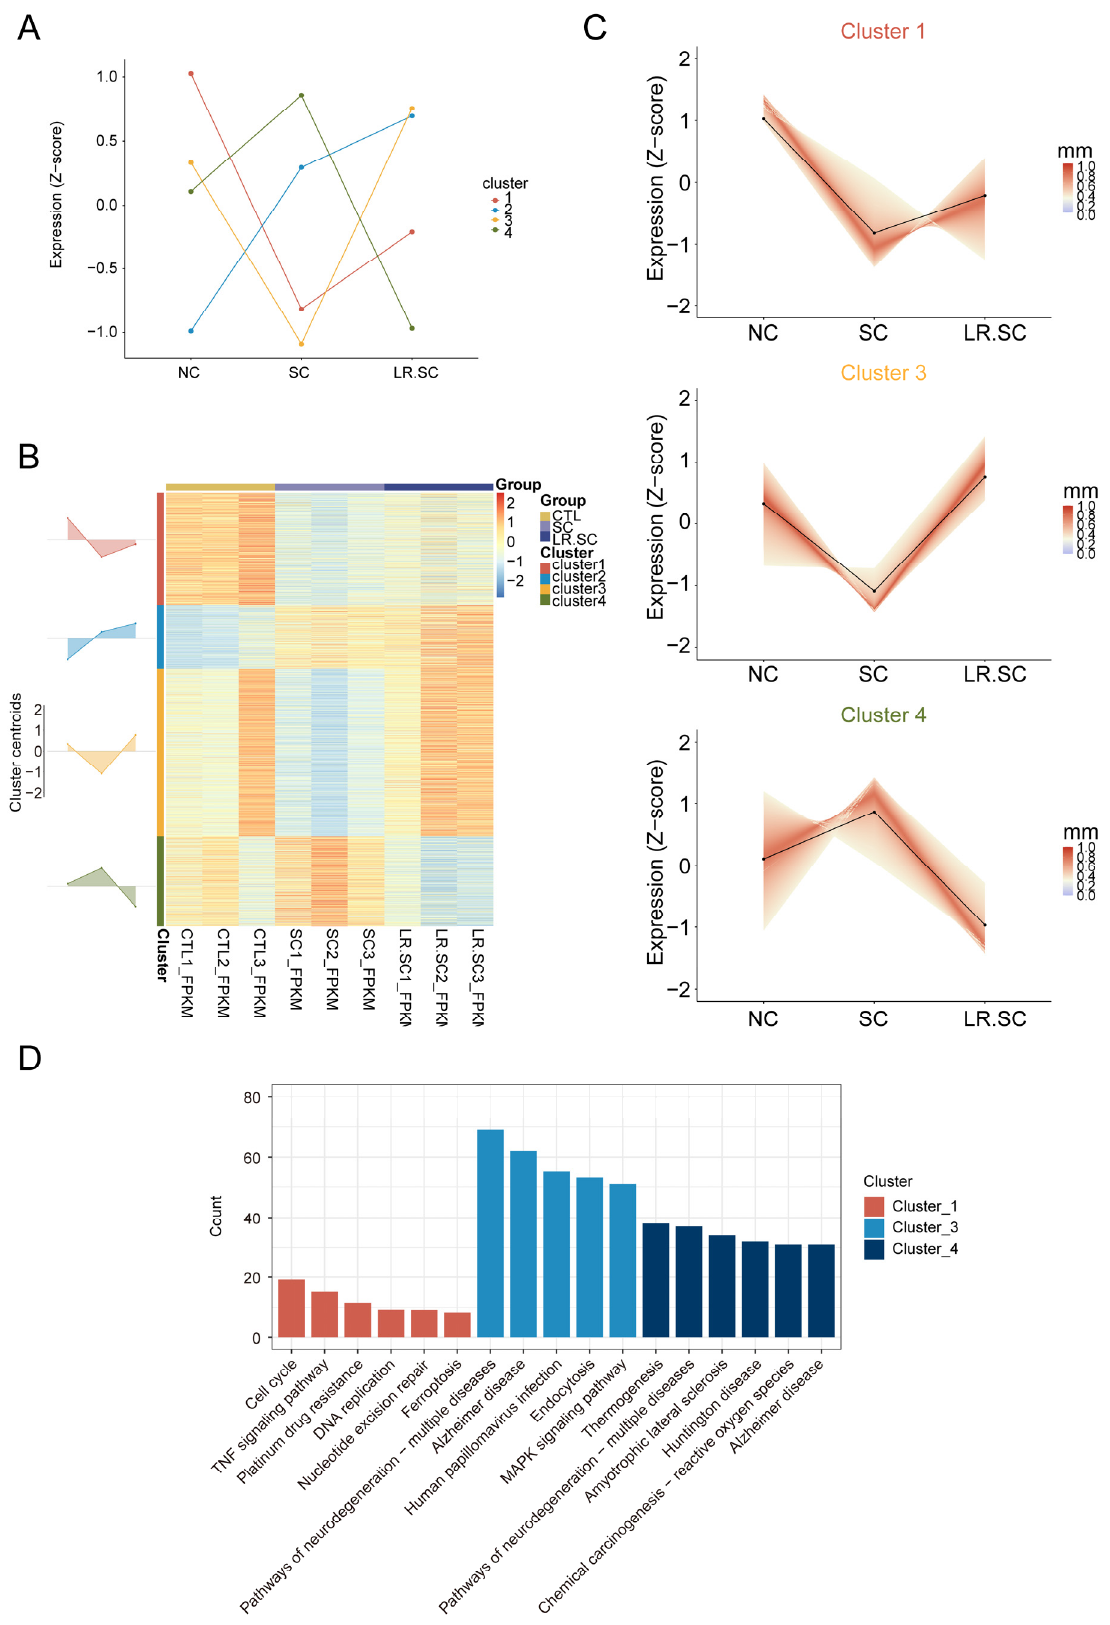
Figure 3. Di ff erent transcriptional changes during L. reuteri ATCC 53,608 treatment inhibit the S. enterica BNCC186354 process. ( A ). Line plot showing the dynamics of gene expression and cluster centroids identi fi ed (cluster number = 4) in di ff erent groups. ( B ). Heatmap representation of four de fi ned clusters with di ff erential gene expression dynamics in di ff erent groups. Area plots (left)